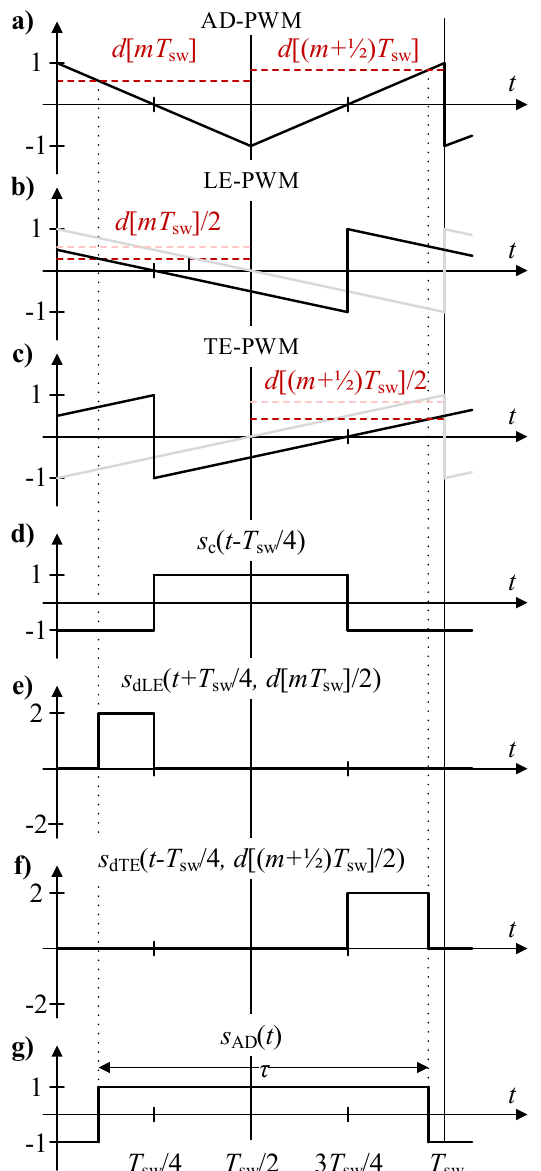
Figure A1. Derivation of switching function for AD-PWM: ( a ) Comparison of an AD-PWM carrier signal (black line) with a sampled duty cycle sampled at mT sw and ( m + 1/2 ) T sw (red dashed